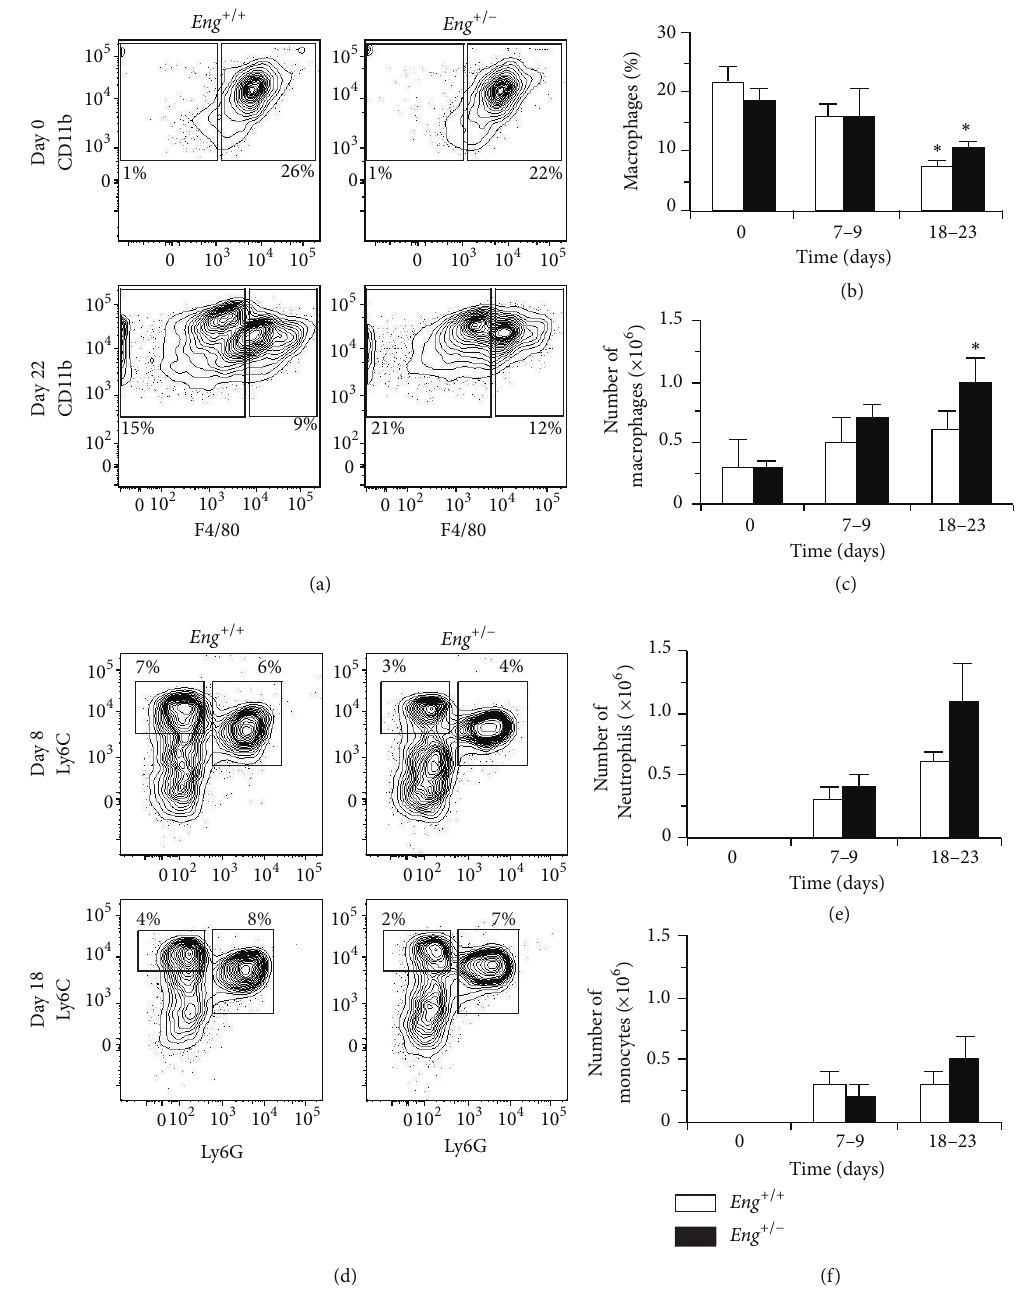
Figure 3: Higher number of infiltrating myeloid cells in colonic lamina propria of colitic Eng +/− mice. (a) Representative flow cytometry contour plots of colonic lamina propria cells, isolated at day 0 and day 22 of a DSS-induced colitis experiment, show the distribution of CD11b + F4/80 + and CD11b + F4/80 − cells. All plots were first gated for CD45 + CD11b + cells (not shown) and the percentage of CD45 + leukocytes is indicated. (b) The distribution and (c) total number of CD11b + F4/80 + cells in Eng +/+ and Eng +/− mice at days 0, 7–9, and 18–23. (d) Representative flow cytometry contour plots of colonic lamina propria cells isolated from both groups of mice at days 8 and 18 of the colitis course. Cells were initially gated for CD11b + F4/80 − cells and analyzed for neutrophils (Ly6C + / − Ly6G + ) and monocytes (Ly6C + Ly6G − ). Histograms in (e) and (f) show the number of neutrophils and monocytes per mouse, respectively. Results represent mean ± SEM ( 𝑁 = 3 experiments for day 0, 5 for days 7–9, and 4 for days 18–23, with 3-4 mice/experiment). ∗ 𝑃 < 0.05 versus corresponding day